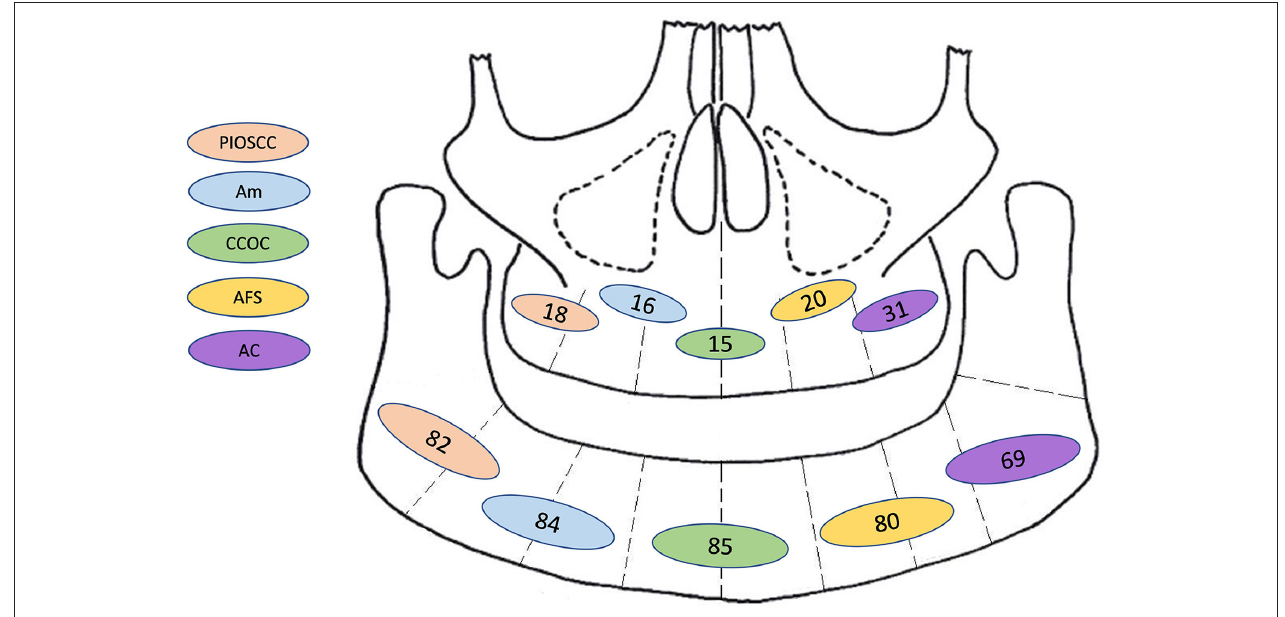
FIGURE 5 | Graphic representation for frequency of site distribution (by jaw only: mandible or maxilla) of the most common combined first and second malignant histological diagnosis. PIOSCC, primary intraosseous squamous cell carcinoma; Am, malignant ameloblastoma; CCOC, clear cell odontogenic carcinoma; AFS, ameloblastic fibrosarcoma; AC, ameloblastic carcinoma; N.B, This diagram only illustrates tumour frequencies in the mandible and maxilla, further information for sub site/laterality was not